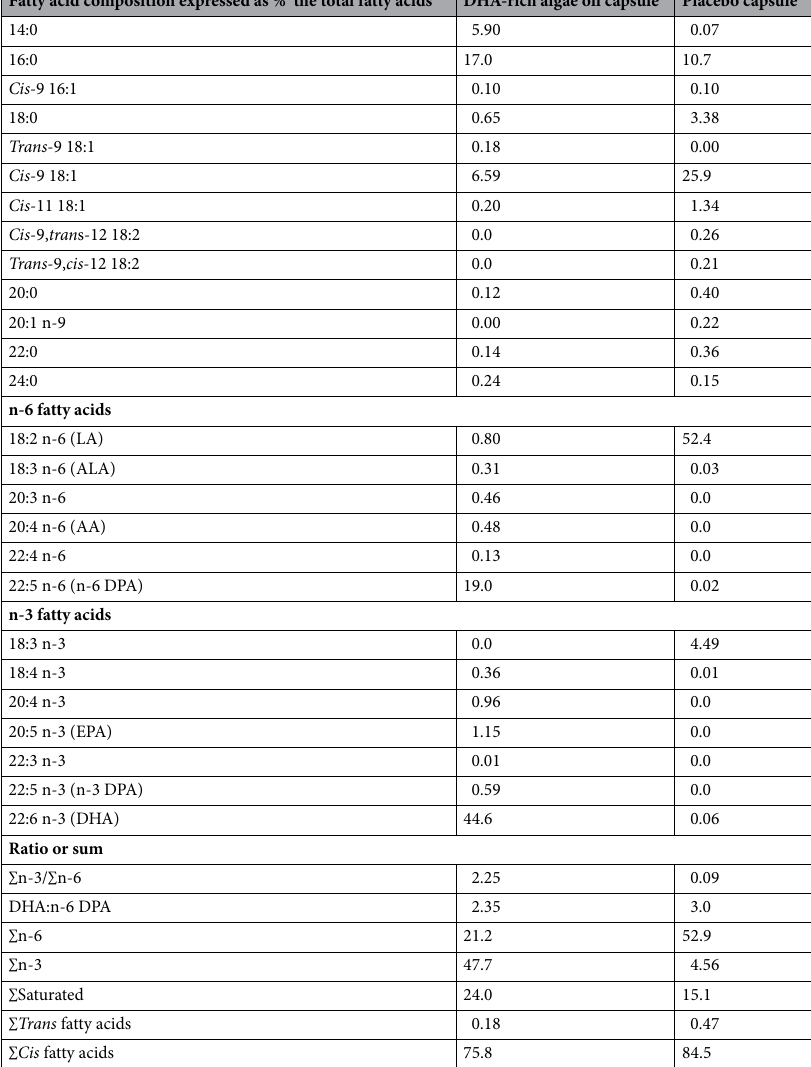
Table 3. Fatty acid composition of the placebo and DHA-rich algae oil capsules. LA linoleic acid, ALA alpha-linolenic acid, AA arachidonic acid, DPA docosapentaenoic acid, EPA eicosapentaenoic acid, DHA docosahexaenoic